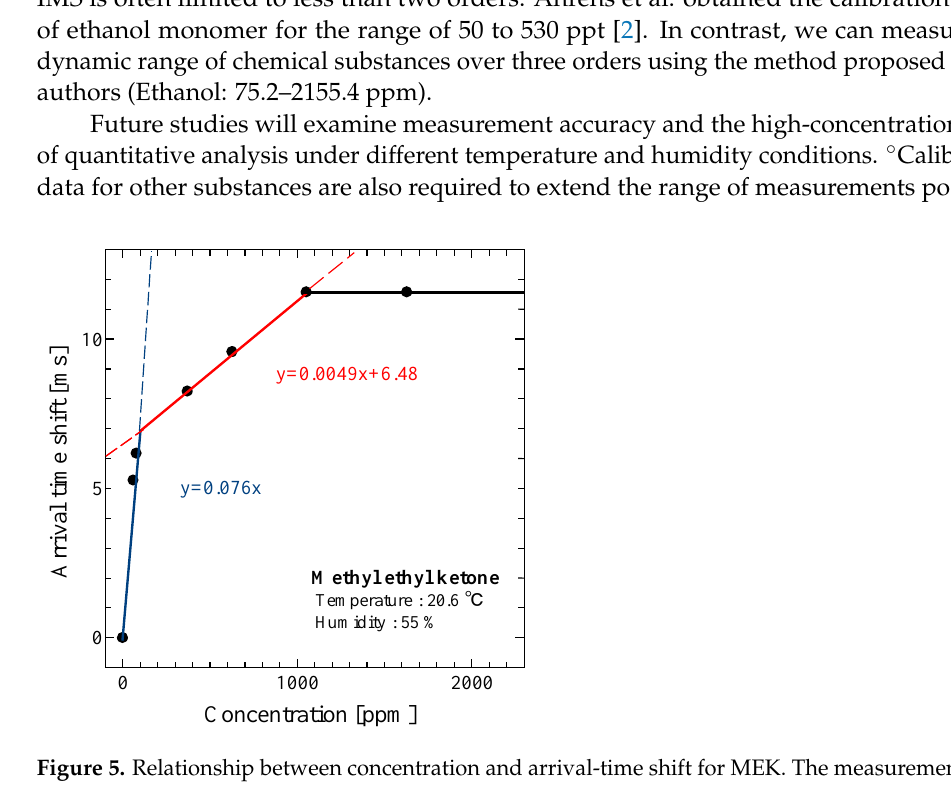
Table 3. Relationship between MEK concentration and arrival time.